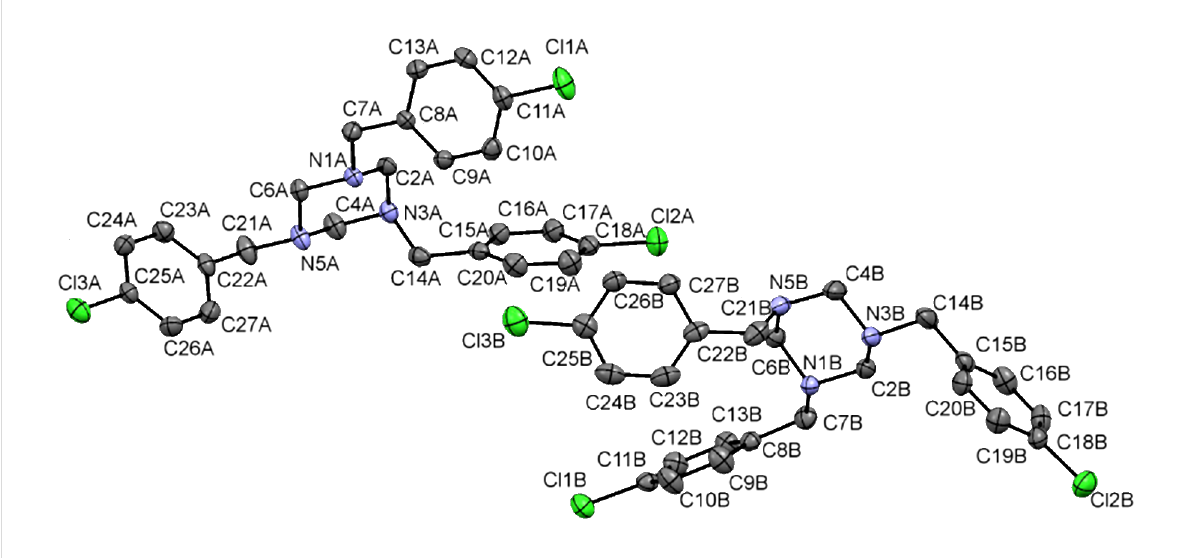
Figure 2: ORTEP diagram of compound 18 depicted with ellipsoids drawn at the 50% probability level and the atom-numbering